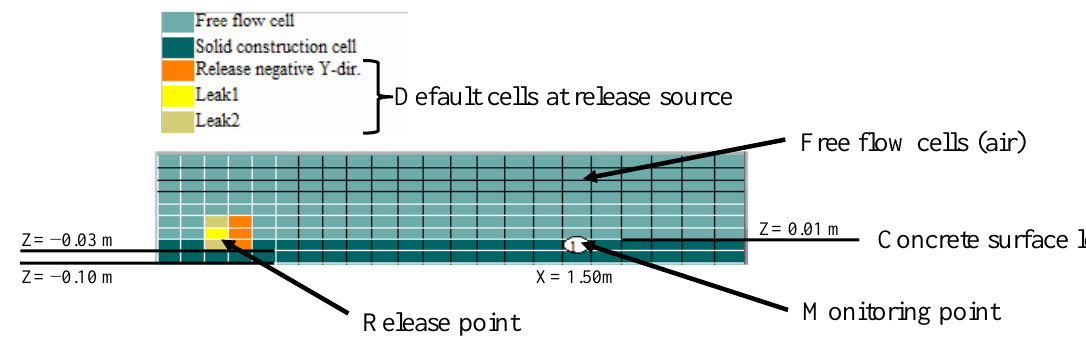
Figure 9. Scheme of LH release in KFX.